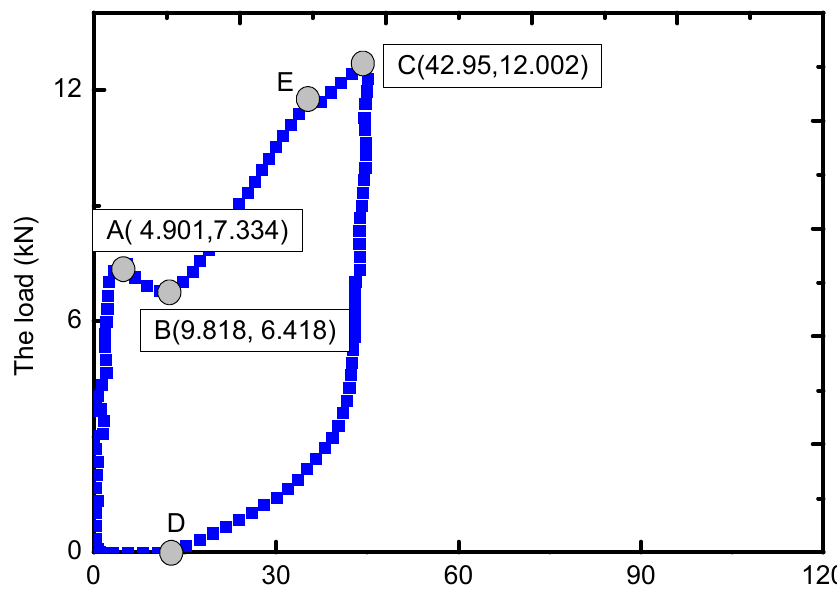
Figure 7. The variation of load with COD for the concrete beam with CFRP